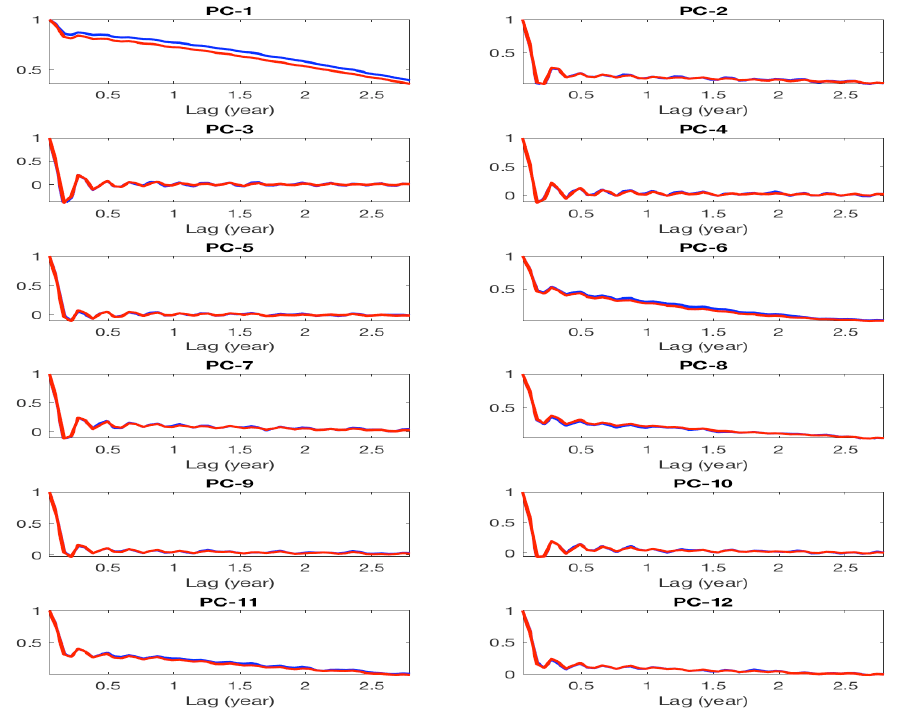
Figure A8. Autocorrelation function (ACF) of the twelve leading PCs of upper-layer stream function anomalies, DAH-filtered in a frequency band f < 5.27 y − 1 : Red, harmonic reconstruction of QG data (HRC; cf. (23)); blue, DAH-MSLM stochastic